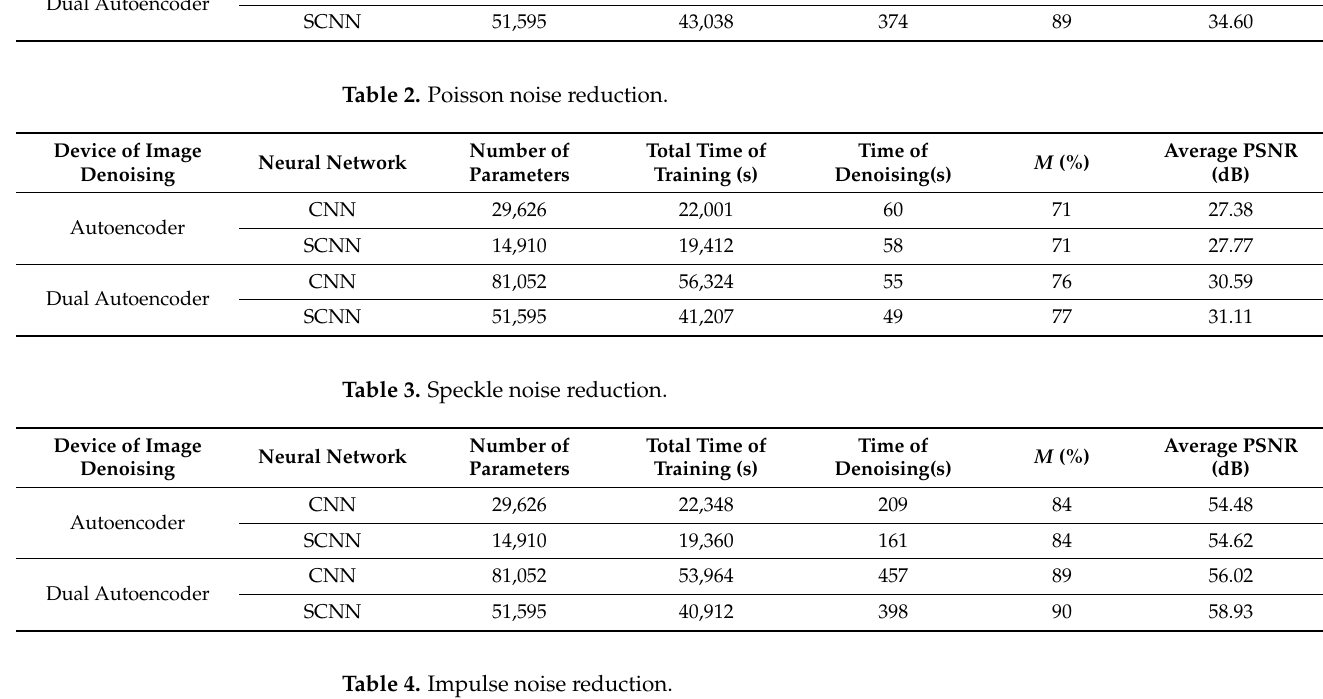
Table 4. Impulse noise